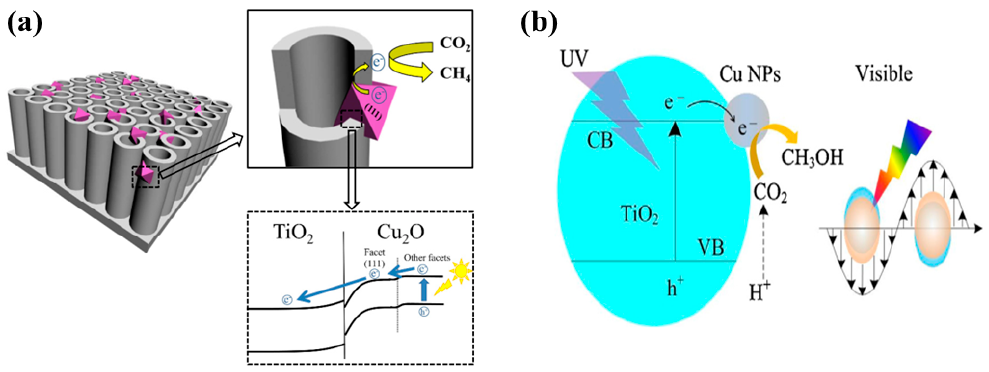
Figure 2. Schematic of the mechanism involved in the photocatalytic conversion of CO 2 into: ( a ) CH 4 employing Cu 2 O NP-incorporating TNT (taken with permission from [50]), and ( b ) CH 3 OH using Cu-modified TNF films (taken with permission from [51]).